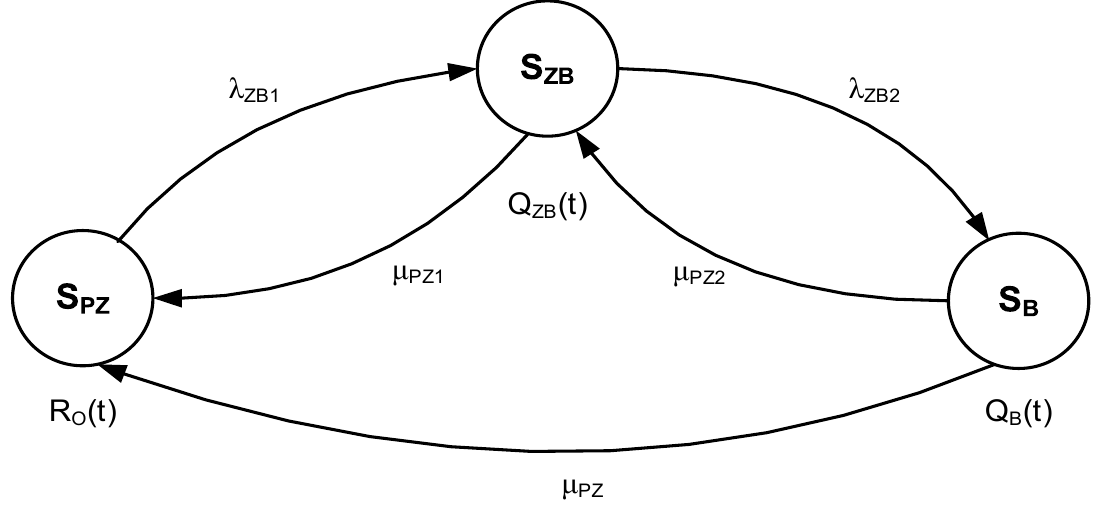
Figure 8. Safety relationships ongoing within a fire alarm system.